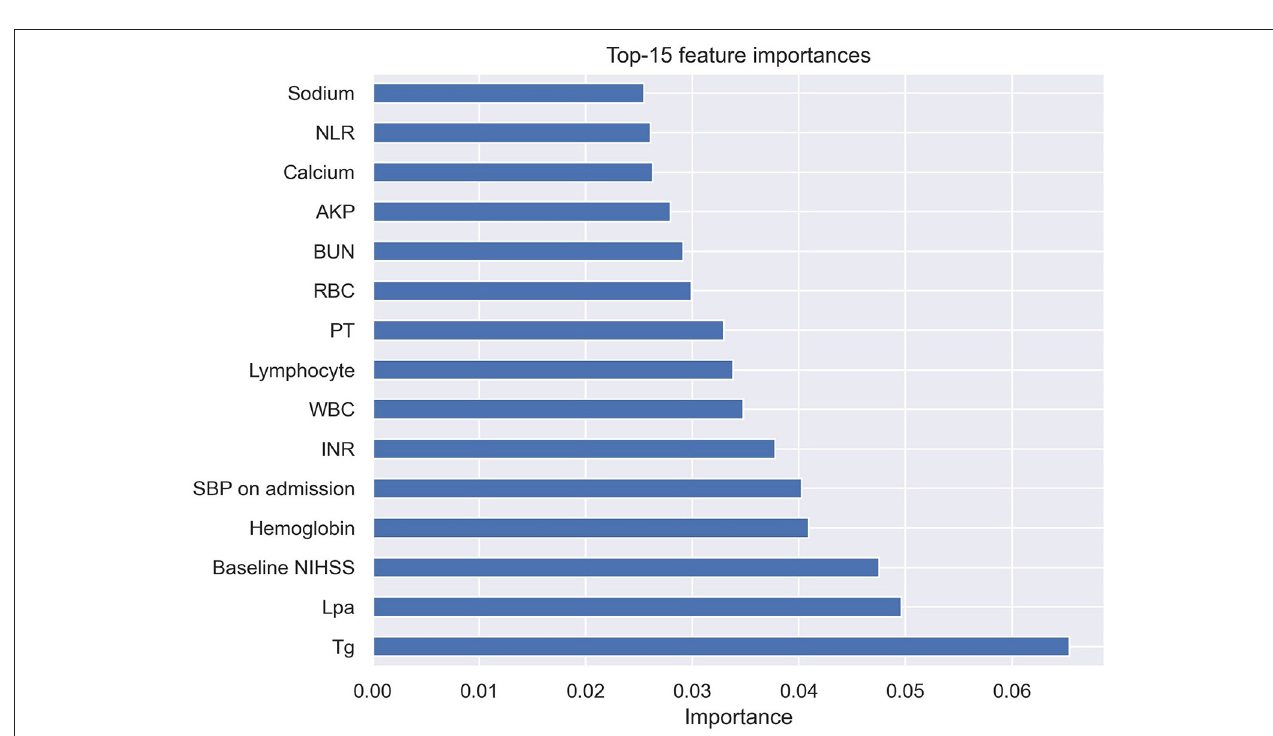
FIGURE 4 | Importance matrix plot of the RF model. Top 15 parameters for predicting HT of AIS after IVT. RF, random forest; HT, hemorrhage transformation; AIS, acute ischemic stroke; IVT, intravenous thrombolysis.